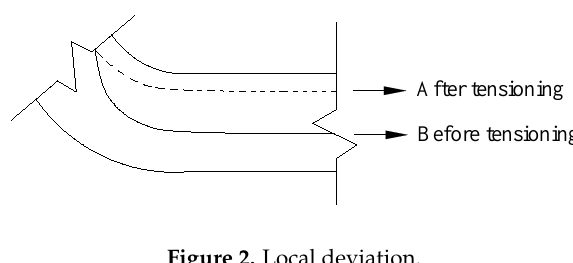
Figure 2. Local deviation.